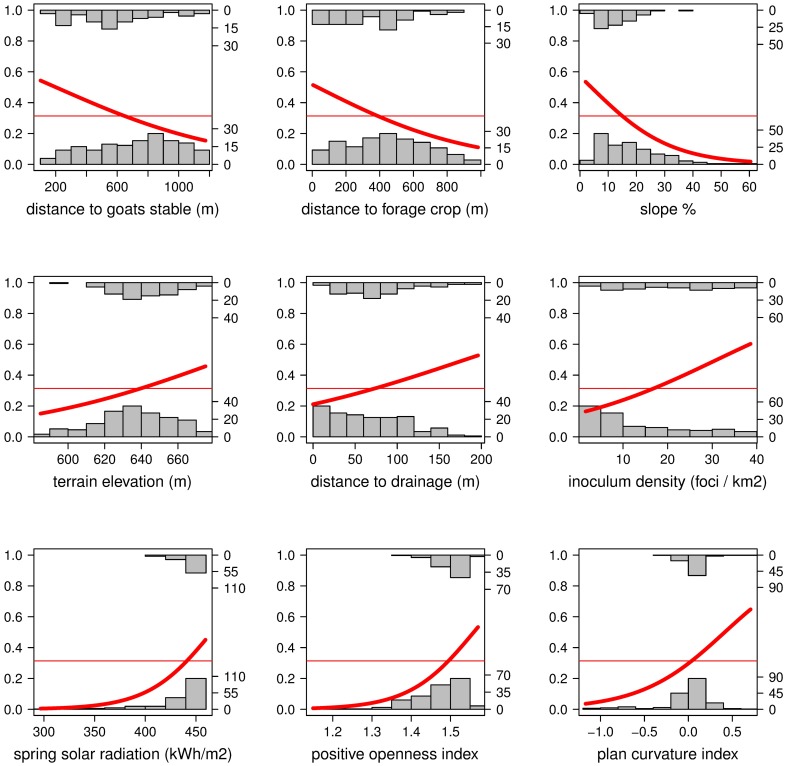
Univariate effects of risk factors analyzed.Fitted univariate logistic regression models for topographic factors with a significant effect on Phytophthora cinnamomi disease probability. The histograms represent the observed data, in the top are the number of cases (diseased) and in the bottom the number of controls (healthy). Frequencies of both can be read from the left Y axis. The red thick line is the predicted probability for the onset of a new P. cinnamomi focus. The thin red line corresponds to the average probability without the effect of any risk factor. Both probabilities can be read from the right Y axis. Positive openness and plan curvature are dimensionless numbers without units.